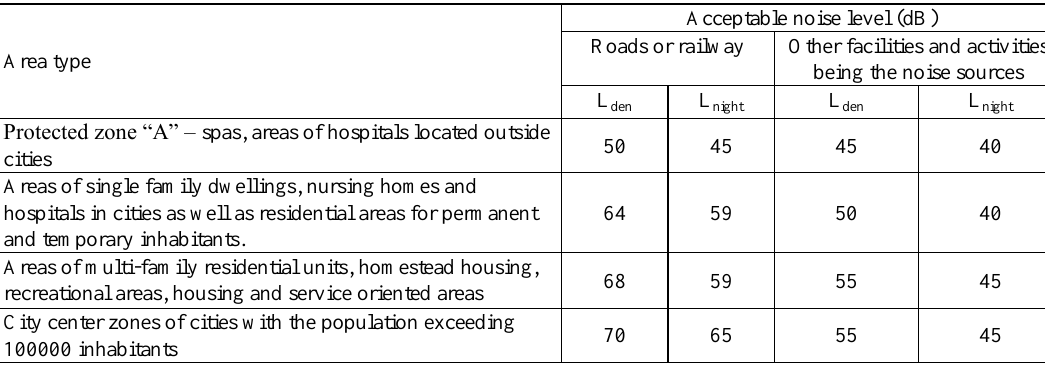
Table 1. Acceptable noise level for particular groups of